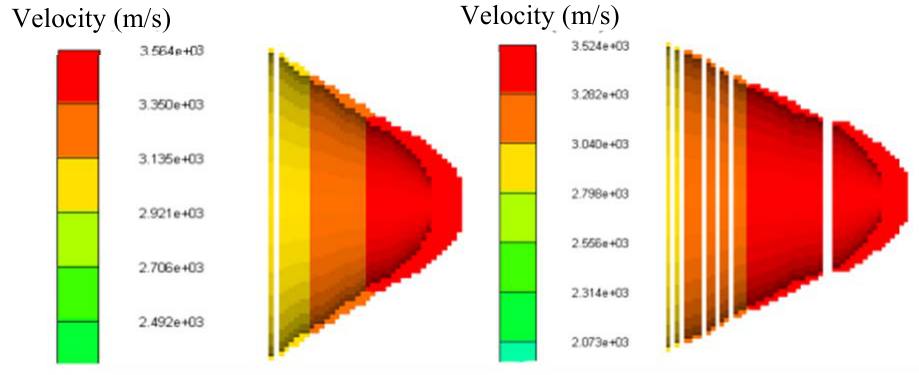
Velocity (m/s) Velocity